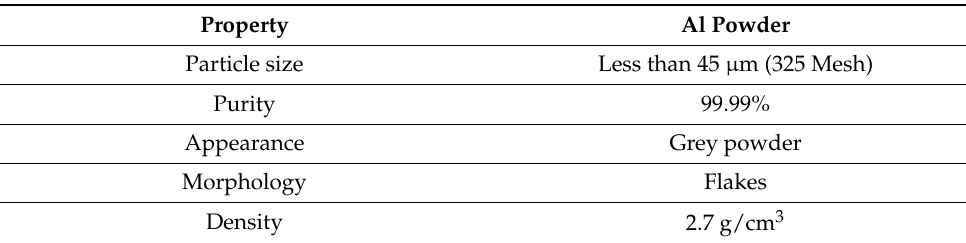
Table 1. Physical properties of the aluminium flakes according to manufacturer (Nanografi Nano Technology,